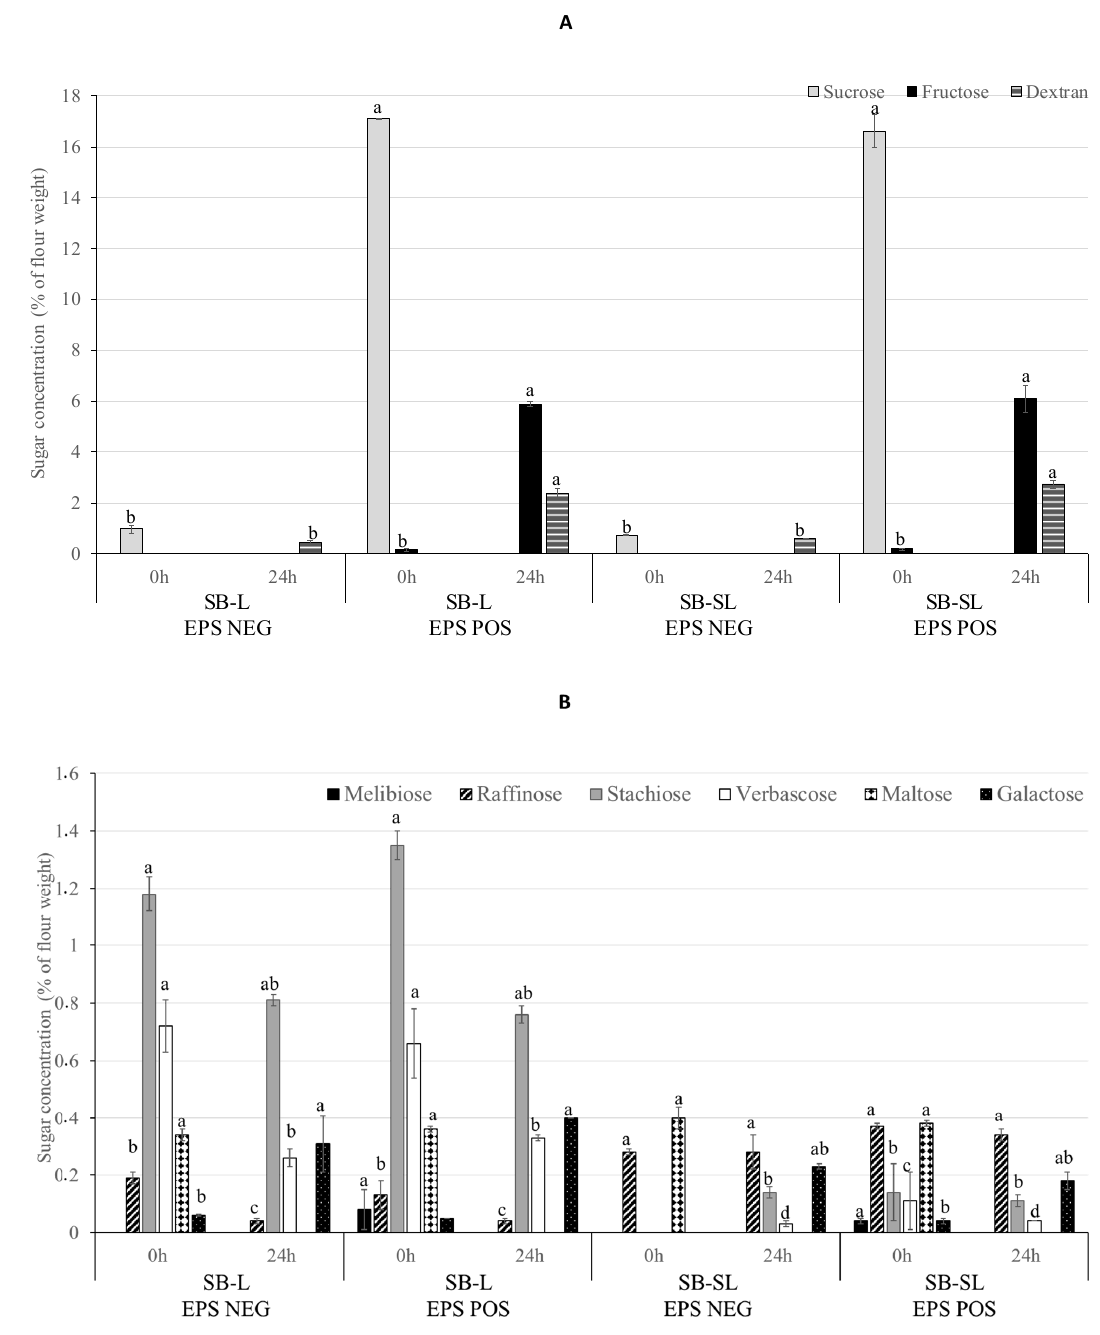
Figure 1. Sugars and dextran concentration (% of flour weight) in control and sucrose-supplemented (16% of flour weight) doughs (DY 333) before and after 24 h of fermentation at 20 °C started by Leuconostoc pseudomesenteroides DSM 20193 (initial cell density of ca. 7 log cfu/g). Panel ( A ) shows sucrose, fructose and dextran concentration; panel ( B ) shows melibiose, raffinose, stachyose, verbascose, maltose and galactose concentration. SB-L EPS NEG, sprouted barley-native lentil dough (30:70 ratio); SB-L EPS POS, sucrose-supplemented sprouted barley-native lentil dough (30:70 ratio); SB-SL EPS NEG, sprouted barley–sprouted lentil dough (30:70 ratio); SB-SL EPS POS, sucrose-supplemented sprouted barley–sprouted lentil dough (30:70 ratio). For each sugar, bars with different superscript letters differ significantly ( p < 0.05).